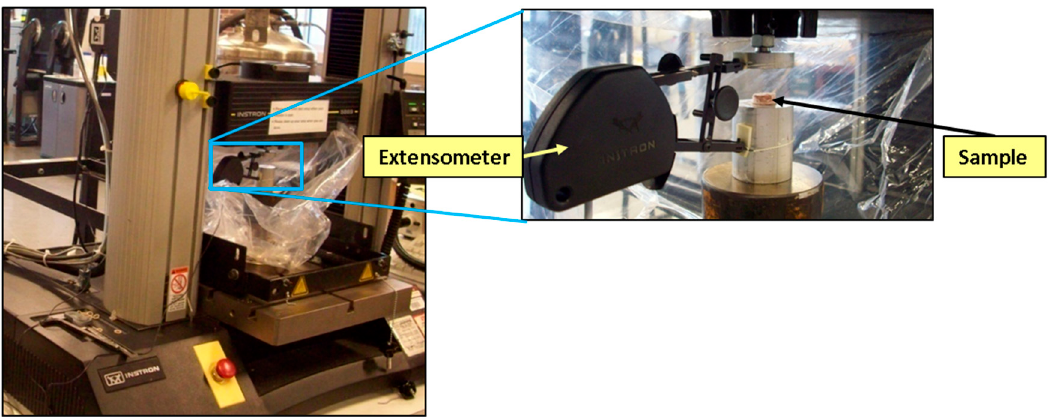
Figure 3. Instron™ 5869 configuration used for compression testing of lyophilized (dry) porcine brain samples at strain rates ranging from 0.00625 to 0.1 s − 1 .